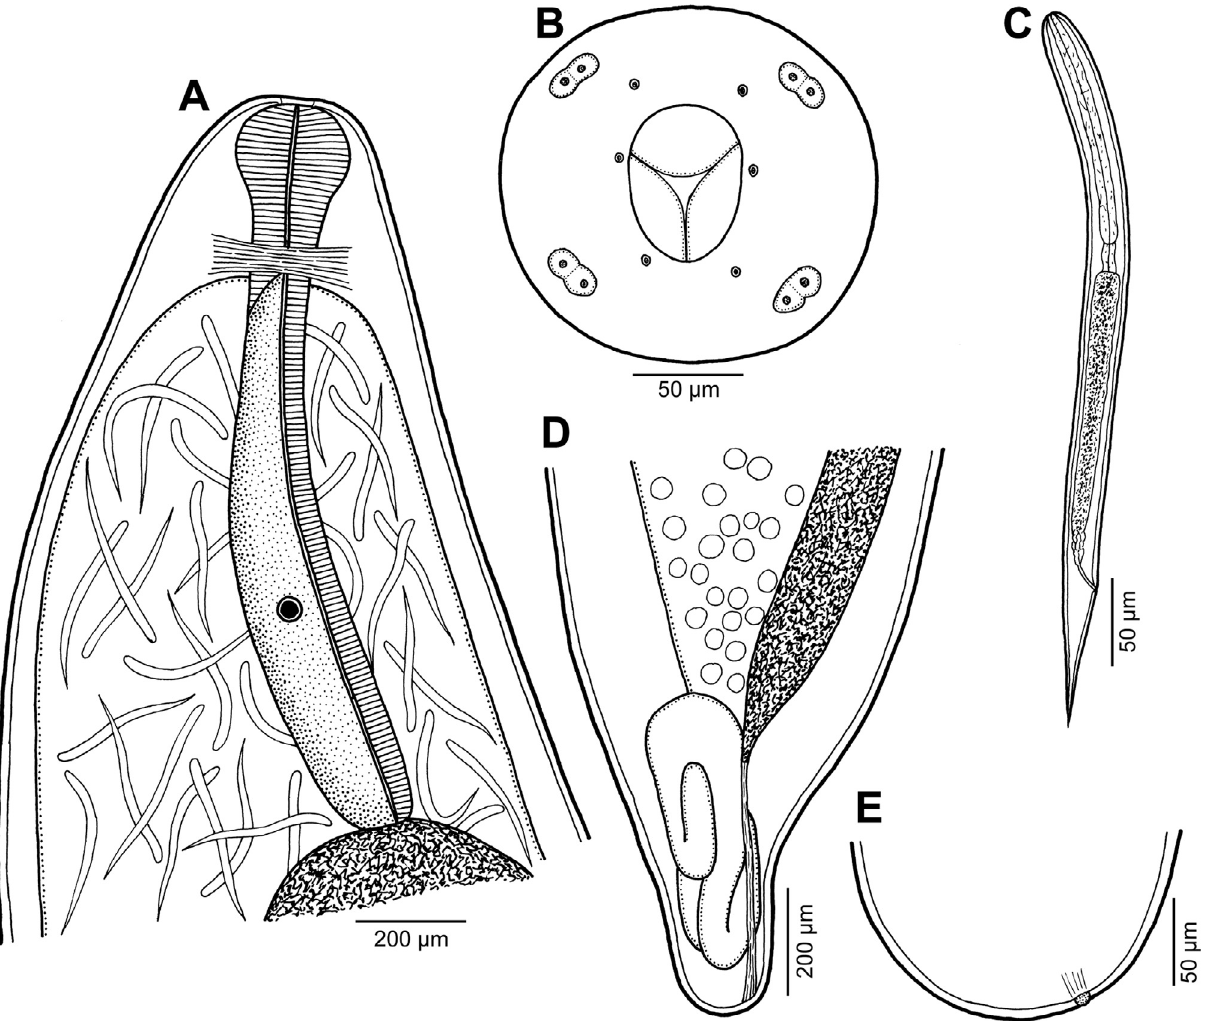
Figure 5. Gravid female of Philometra fasciati Moravec & Justine, 2008 from Epinephelus fasciatus . A: Anterior end, lateral view. B: Cephalic end, apical view. C. Larva from uterus, lateral view. D: Posterior end, lateral view. E: Caudal extremity, lateral